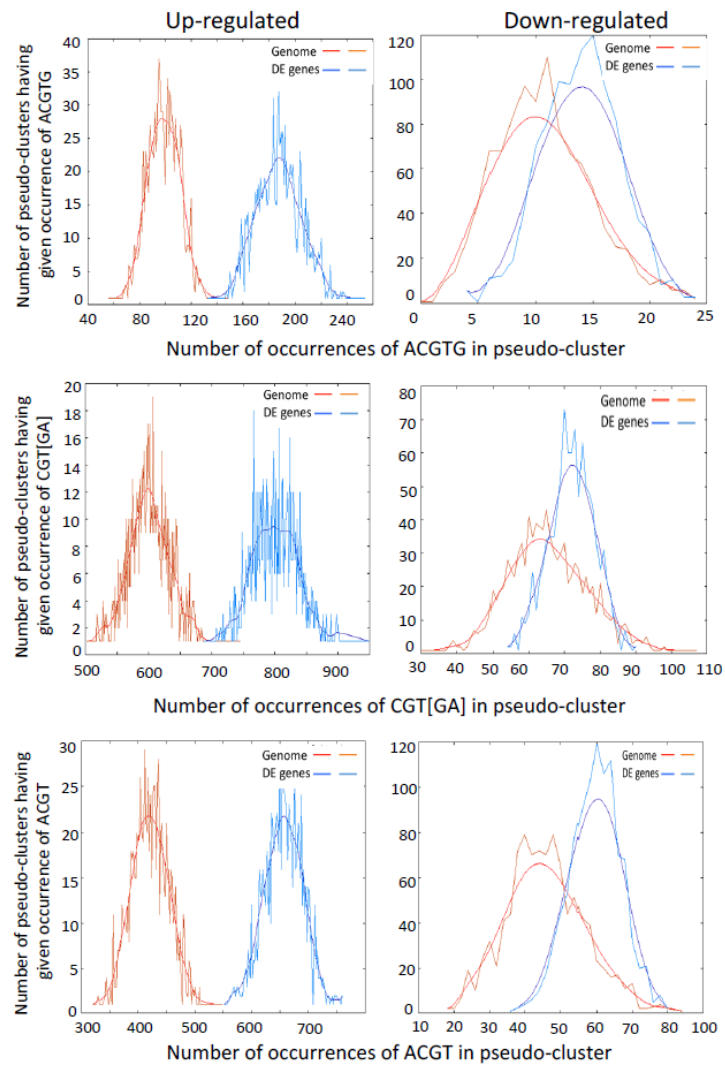
Figure 5. VOZ-binding sites in the promoters of up- and down-regulated DE genes. POBO analysis of VOZs binding motif, G-box core sequence (ACGTG) (top panels), NAC consensus sequence (CGT[GA]) (middle panels), and LS-7 cis -element (ACGT) (bottom panels) in the − 1000 bp upstream of TSS. A total of 1000 pseudoclusters were generated from 101 up-regulated (left panels) and 11 down-regulated genes (right panels) and genome background. The jagged lines show the motif frequencies from which best-fitted curve is derived. VOZs binding sites are significantly (two-tailed p < 0.0001) over-represented in the upstream sequences of both up- and down-regulated